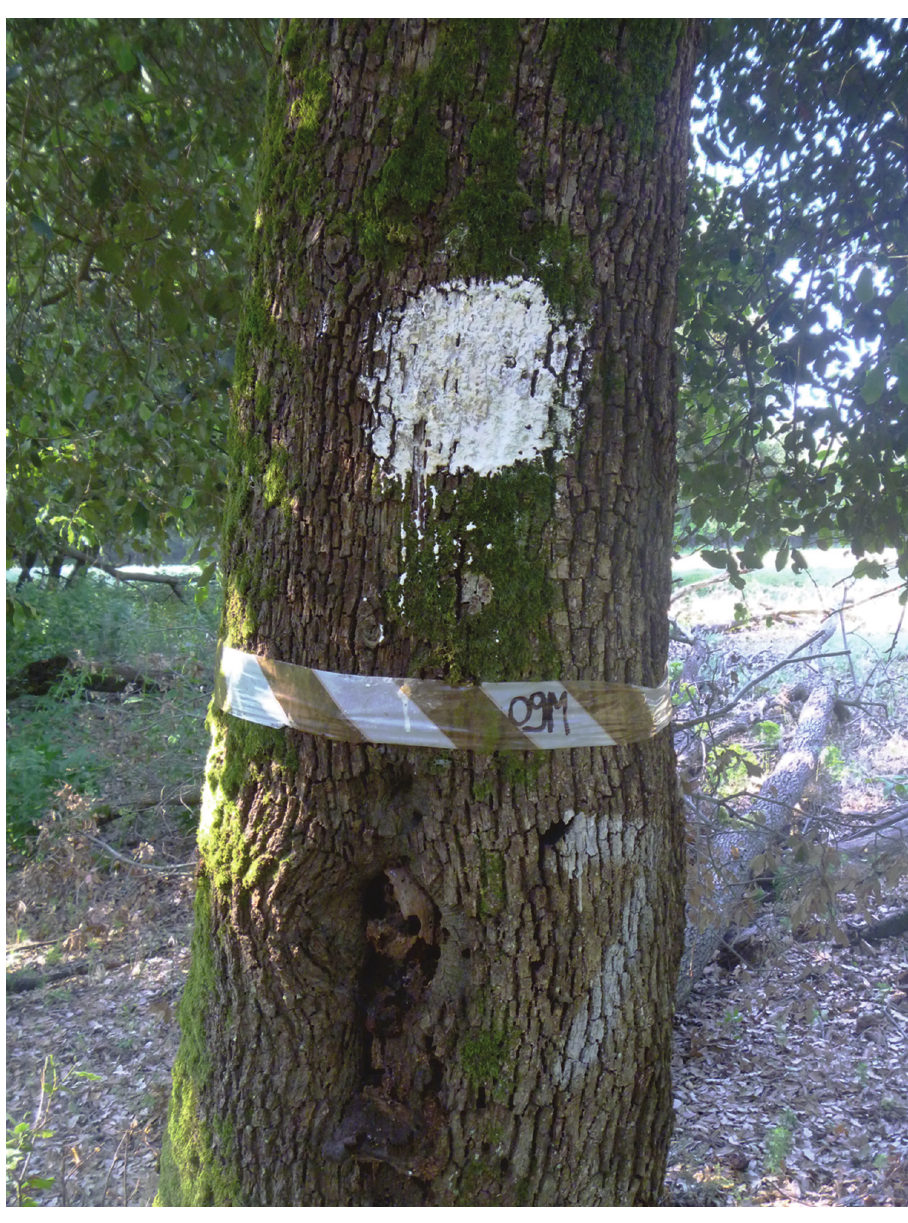
Figure 2. Tree with manna solution smeared on the bark, used as feeding station for longhorn beetles (Photo by L. Redolfi De